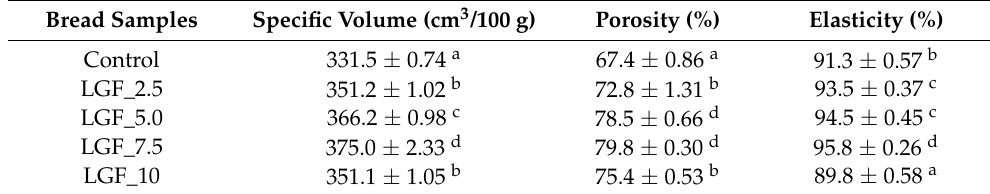
Table 2. Physical characteristics of the bread samples with different levels of LGF addition in wheat flour. Bread Samples